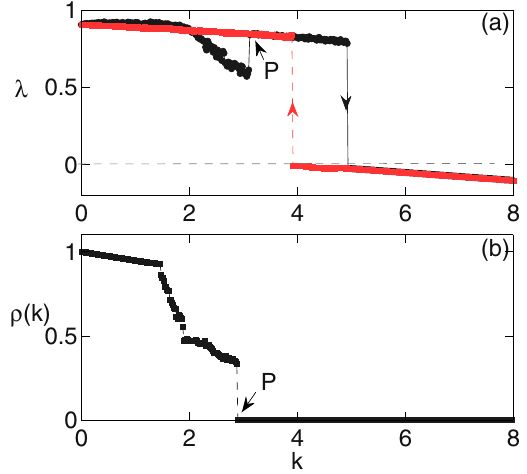
Figure 4. ( a ) The largest Lyapunov exponent, λ for both forward (black) and backward (red) continuations and ( b ) the normalized synchronization error, ρ ( k ) for forward continuation of N coupled Lorenz oscillators given by Eq. (7) as a function of the coupling strength, k . The marked point P denotes the onset of the synchronization regime. Other parameters are N = 100, and Q =